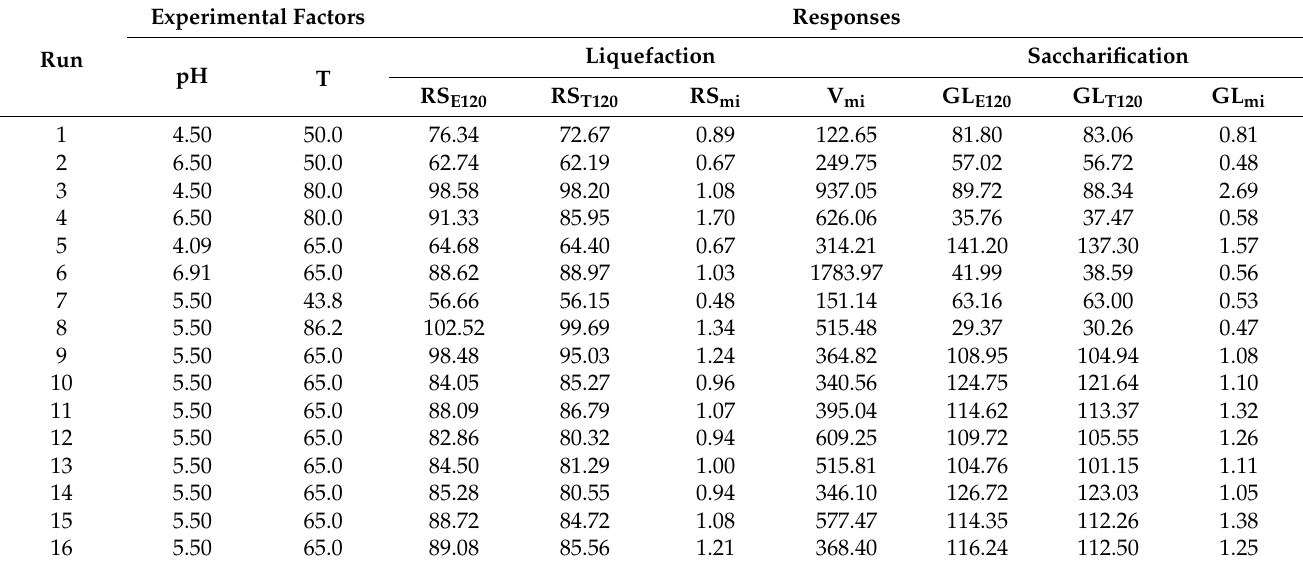
Table 1. Central composite design and responses for the study of pH and temperature in the sequential enzymatic